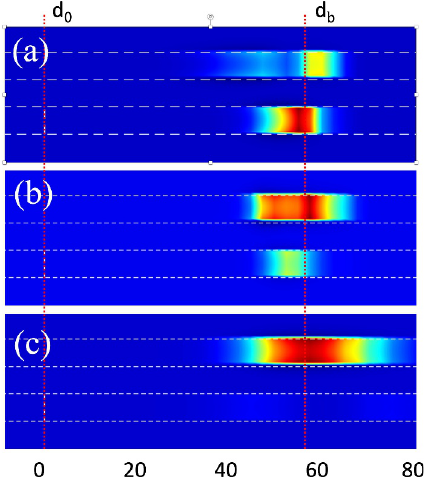
Figure 2. Simulation for three pulses of energy W = 2 . 25 and di ff erent time width: a) ∆ t = 10, b) ∆ t = 15, c) ∆ t = 40. Lines d 0 and d b mark the source and output positions.